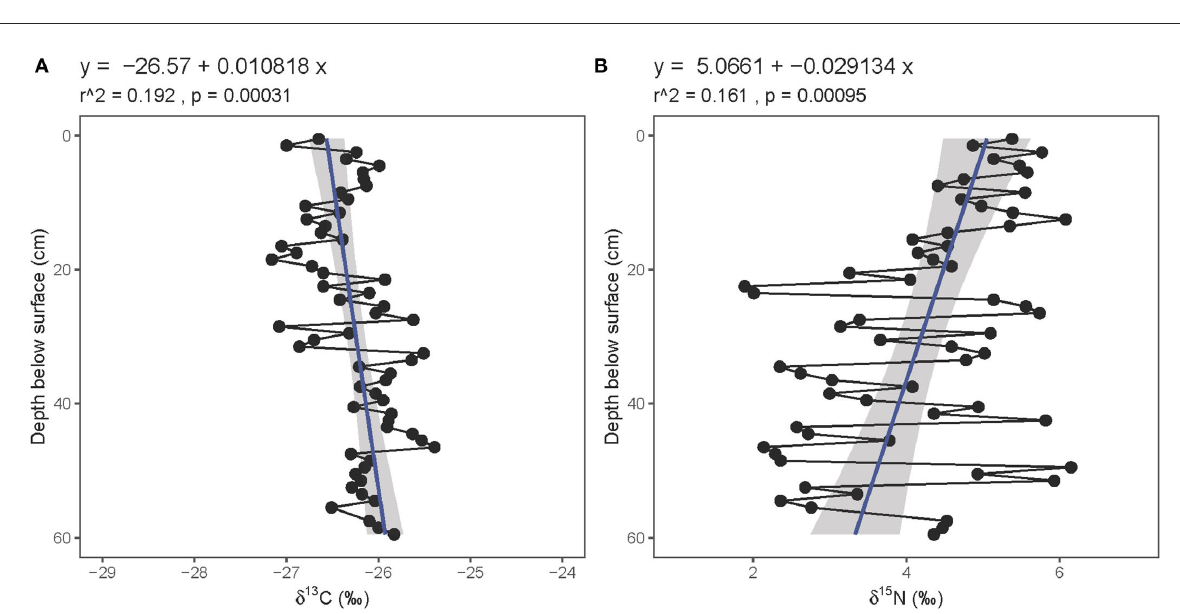
several environmental variables, including precipitation and vegetation type. With the two precipitation outliers removed, neither guano δ 13 C nor δ 15 N values are strongly related to the same-year precipitation amount ( r 2 = 0.108, p = 0.12; r 2 = 0.0874, p = 0.14). Guano δ 13 C values are similarly unrelated to